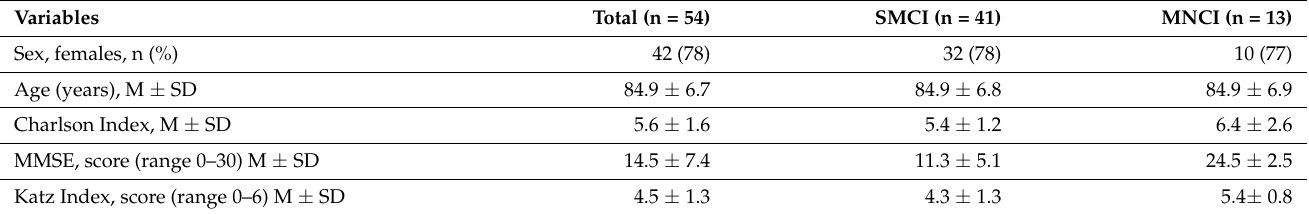
Table 3. Participant